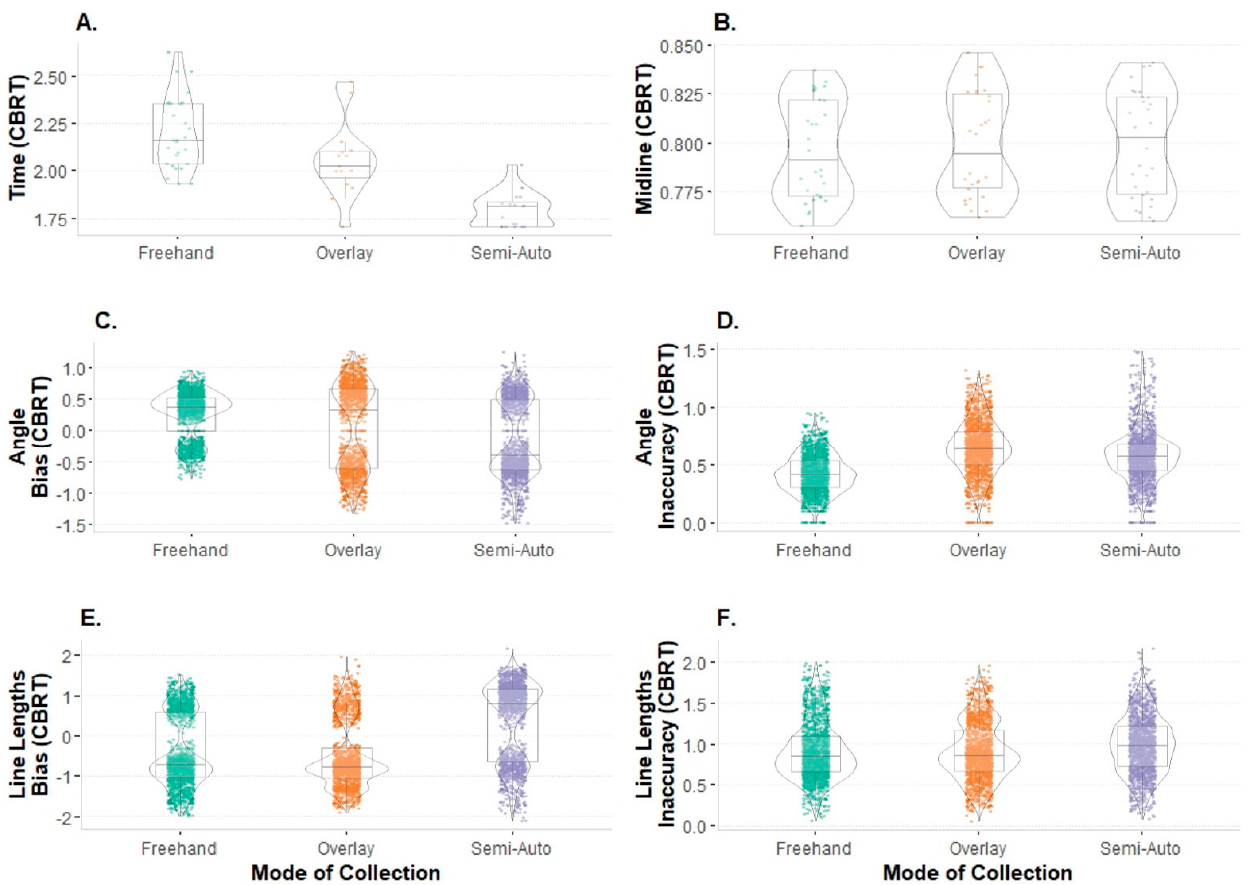
Figure 6. Violin plots of dataset by mode, transformed and representing distributions and underly- ing box-and-whisker plots visualizing summary statistics: ( A ) time; ( B ) midline ratio; ( C ) bias in the angle placement; ( D ) inaccuracy in the angle placement; ( E ) bias in the line lengths; ( F ) inaccuracy in the line lengths. (CBRT = cube root.)